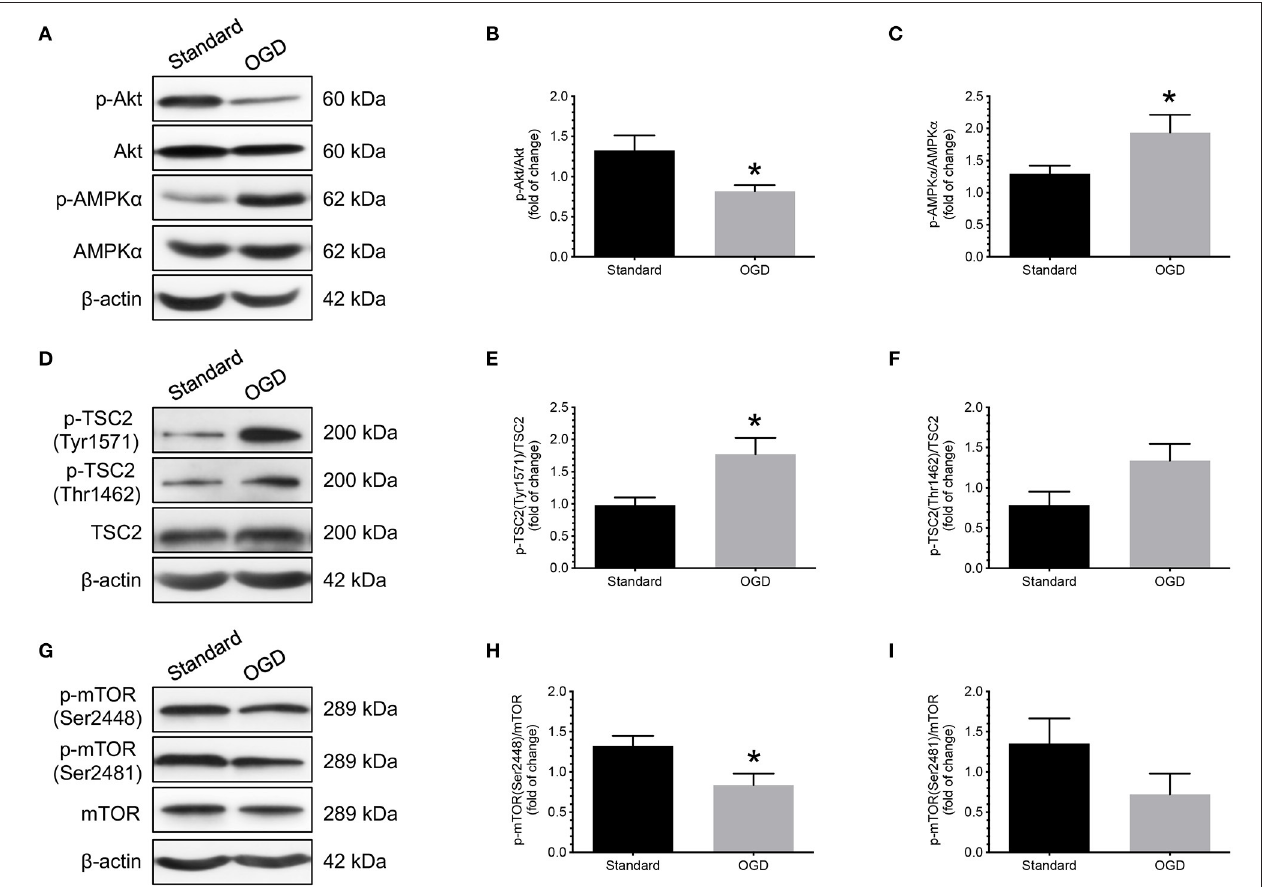
FIGURE 3 | Effects of OGD on the changes of Akt, AMPK α , TSC2, and mTOR phosphorylation in human cytotrophoblast cells. Cytotrophoblast cells were isolated from normal term placentas and cultured at either OGD or standard conditions for 24h. Cytotrophoblast cells subjected to OGD treatment had decreased phosphorylation of Akt and increased phosphorylation of AMPK α than the cells cultured under standard conditions (A–C) . OGD treatment also led to increased TSC2 (Tyr1571) phosphorylation (D,E) and decreased mTOR (Ser2448) phosphorylation (G,H) . There were no significant differences in the measurements of p-TSC2 (Thr1462)/TSC2 and p-mTOR (Ser2481)/mTOR between these two groups (F,I) . (A,D,G) Representative blots show the levels of phosphorylated and total forms of Akt, AMPK α , TSC2, and mTOR. β -actin was used to normalize loading variability. (B,C,E,F,H,I) Data are presented as mean ± SEM; n = 8 for each group. *, P < 0.05; compared with cells cultured at standard conditions based on Student’s t -test. Standard, standard culture conditions; OGD, oxygen-glucose